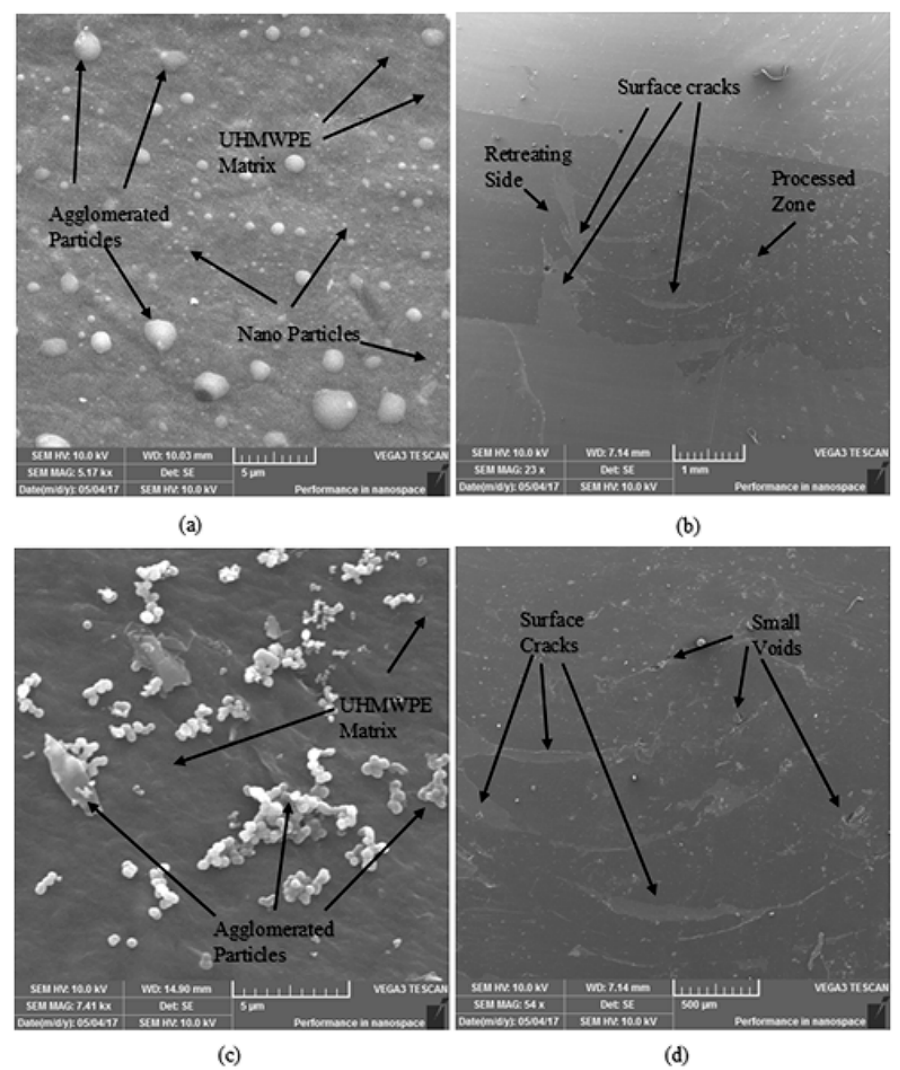
Figure 5. SEM images showing various defects at ( a ) high ( v and f ), ( b ) low ω , ( c ) high ( f and v ), and low T , and ( d ) low ω high f.